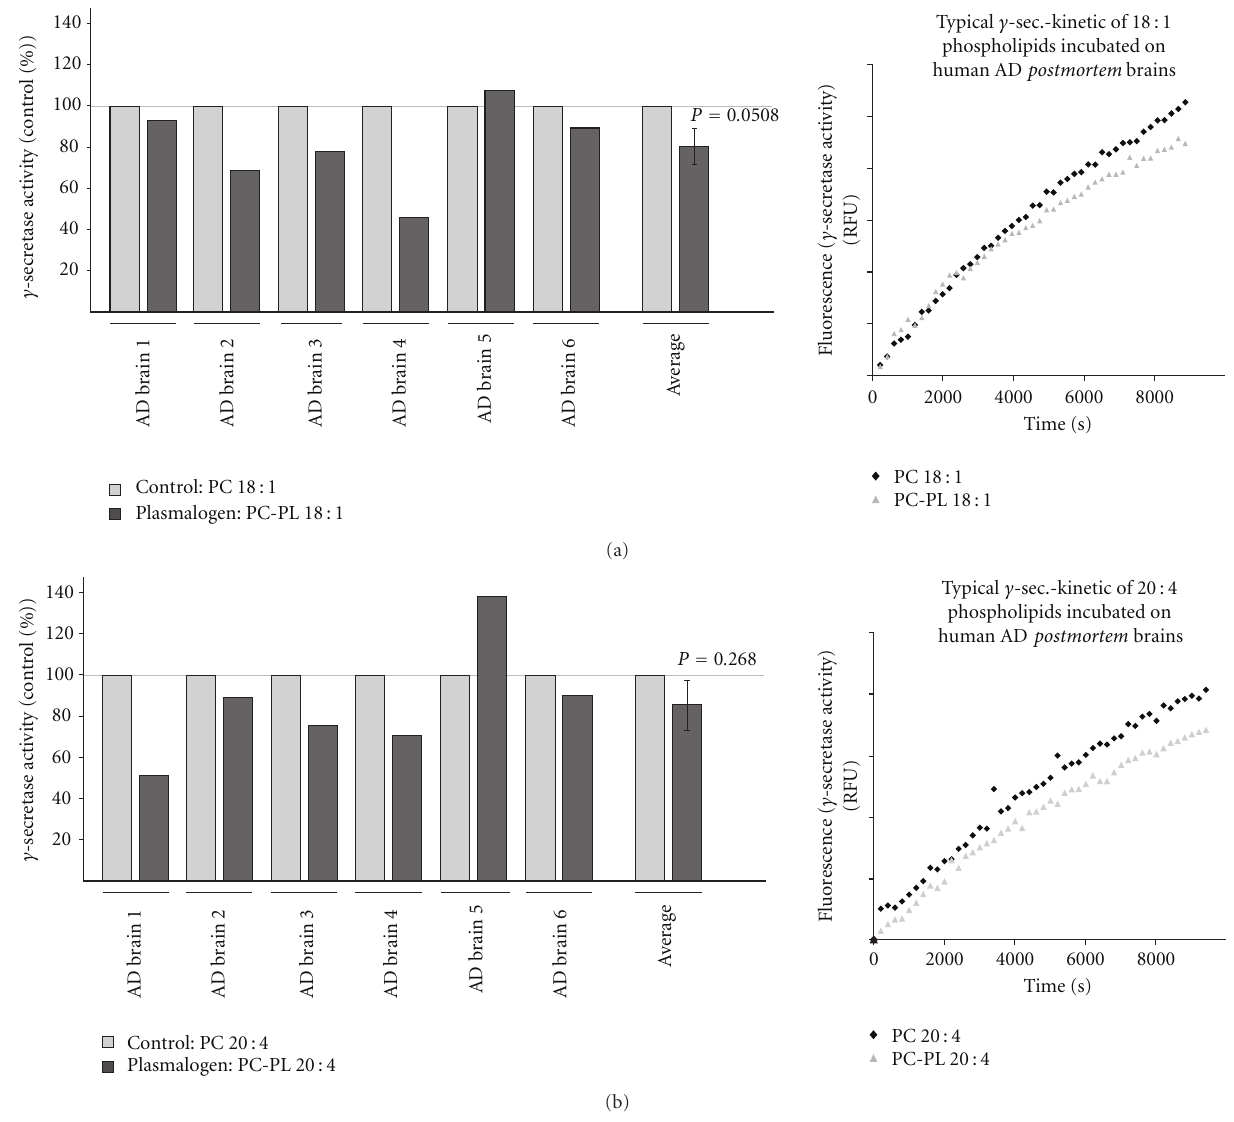
Figure 6: E ff ect of PC-PL 18 :1 and PC-PL 20:4 on γ -secretase activity in purified membranesof humanAD postmortem brains. Membranes of six human AD postmortem brain samples were purified and incubated with (a) PC-PL 18: 1 and the corresponding phospholipid PC 18 :1 or (b) PC-PL 20: 4 and PC 20:4 as control. PC-PLs and corresponding phospholipids were incubated in a final concentration of 100 μ M and γ -secretase activity was determined with a fluorometric assay. (a, b) Representative kinetics were shown. Illustration and statistical significance are as described for Figure